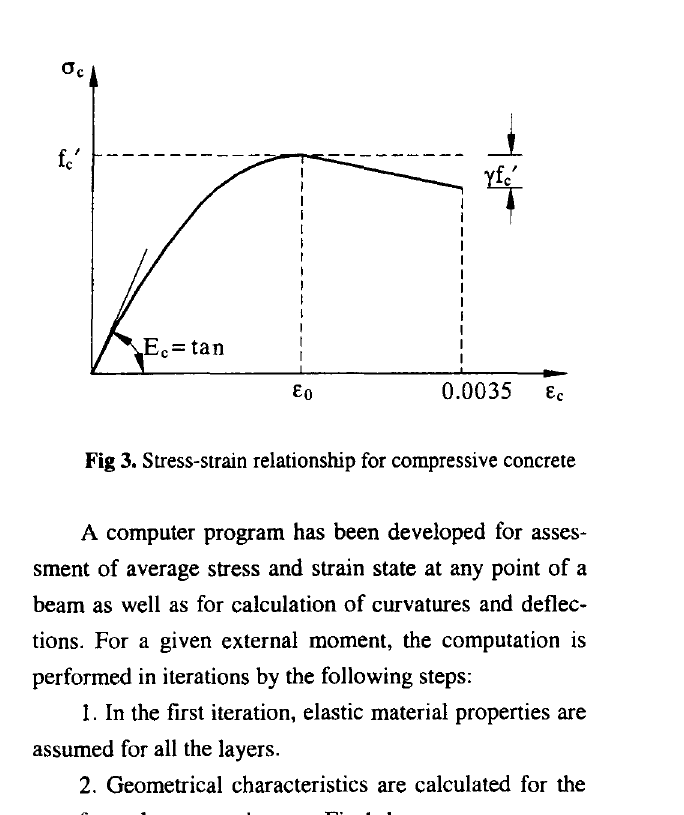
Fig 3. Stress-strain relationship for compressive